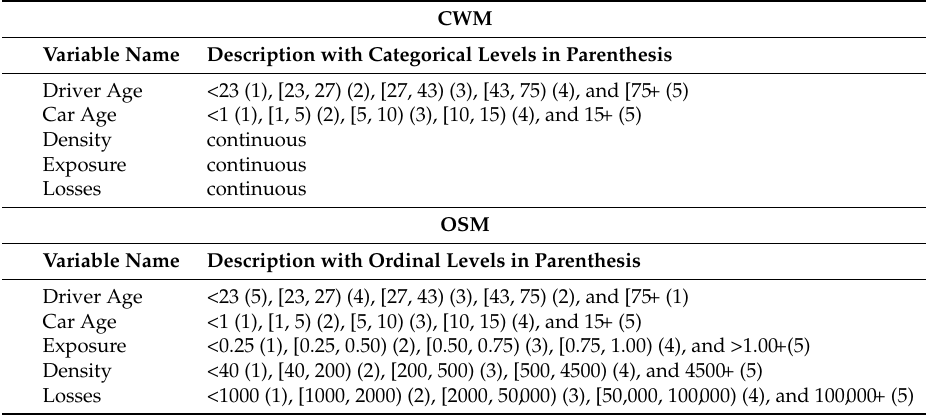
Table 1. Summary of the variables used in the cluster-weighted model (CWM) and the ordered stereotype model